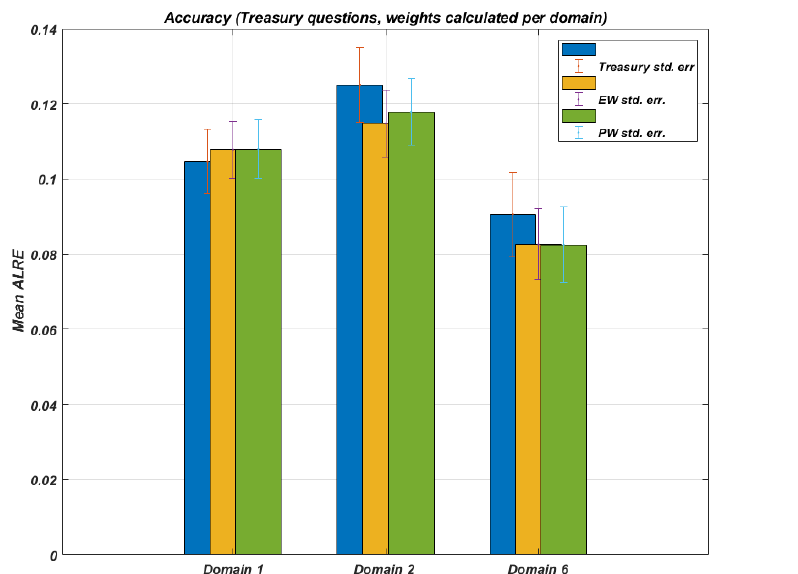
Figure 6. Accuracy of Treasury forecasts compared to EW and PW forecasts, with weights calculated only based on the questions answered by Treasury. The figure shows the mean ALRE of forecasts and standard error intervals. Domain 1 = Australian economic growth, Domain 2 = Australian Macro-economic indicators, Domain 6 = OECD and other country economic